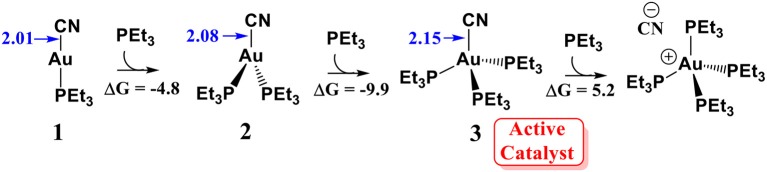
Reaction energies (ΔG) for the association of PEt3AuCN with PEt3 ligand. All energies are in kcal/mol; All bond lengths are in Å.